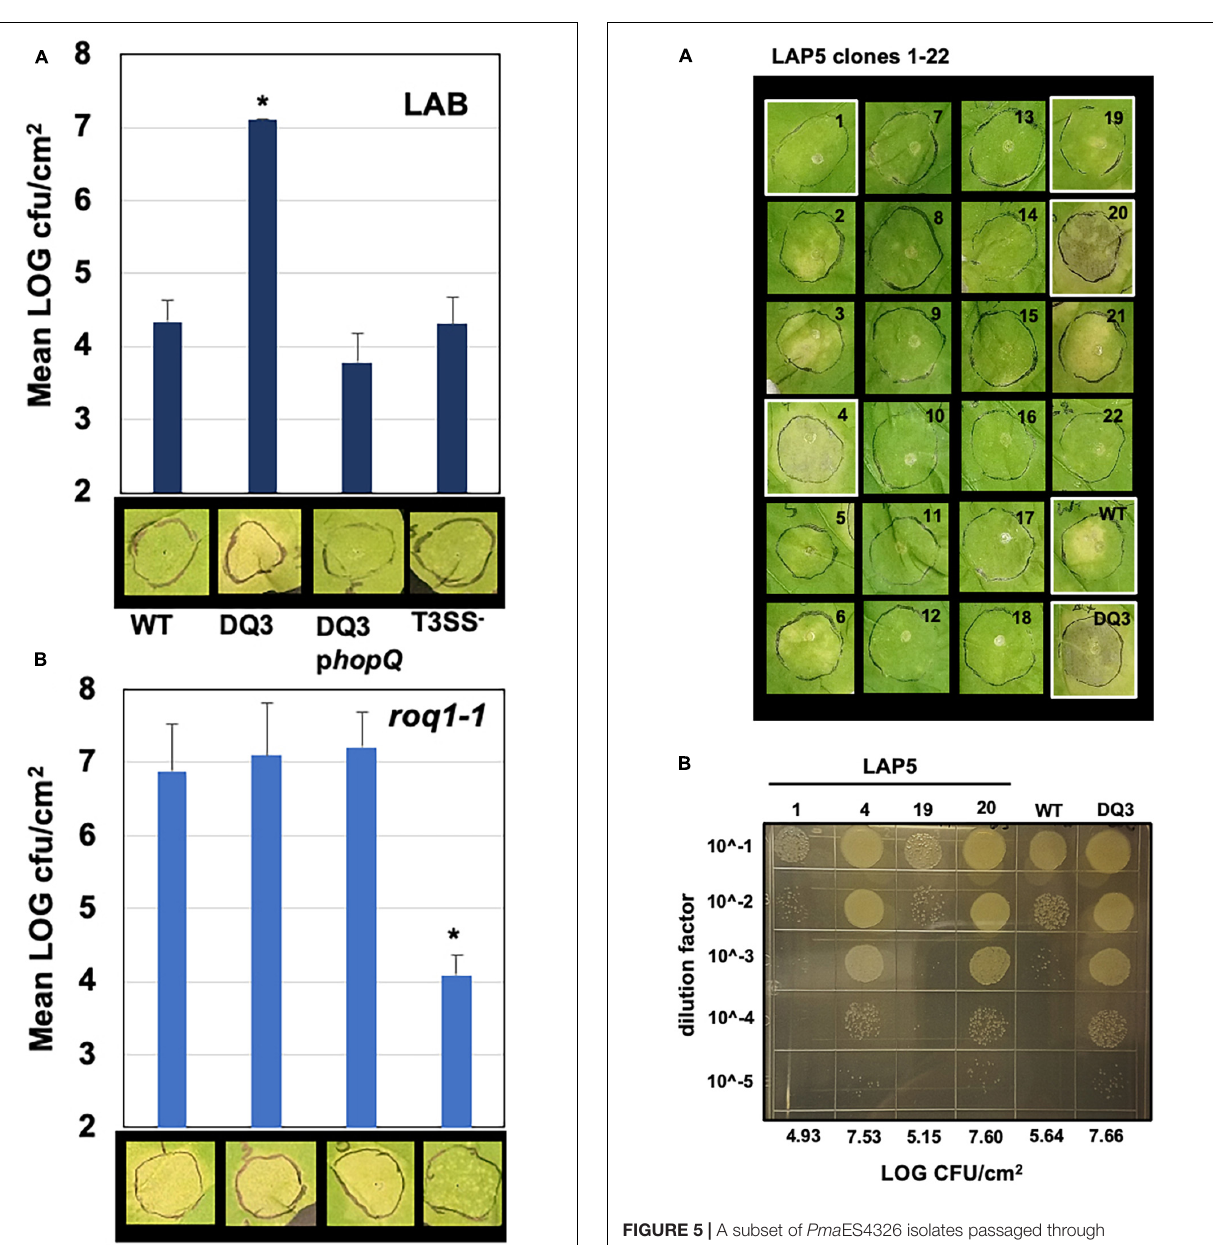
FIGURE 5 | A subset of Pma ES4326 isolates passaged through N. benthamiana gain disease compatibility. (A) Two isolates out of 22 Pma ES4326 lineage A (LA) passage 5 (P5) isolates produce disease symptoms in the N. benthamiana LAB accession comparable to the targeted Pma DQ3 ( (cid:49) ICE-DQ) strain. Leaves were photographed eight days post inoculation with 3 × 10 4 CFU/mL bacterial suspensions. (B) Tenfold dilution series 10 µ L spot plate for assessing bacterial load of select strains highlighted in white in panel A. 3xmCherry Sp R recipients. Conjugations between these strains were then plated on kanamycin and spectinomycin selective media ( Figure 6A ). No kanamycin and spectinomycin resistant mutants or exconjugants were recovered from the Pto